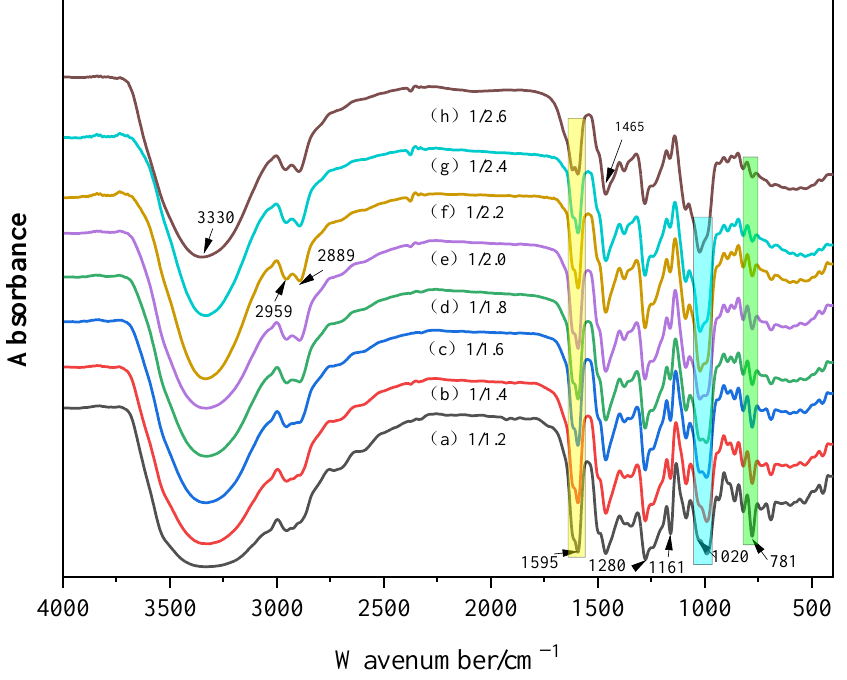
Figure 4. TR − FTIR spectra of CF